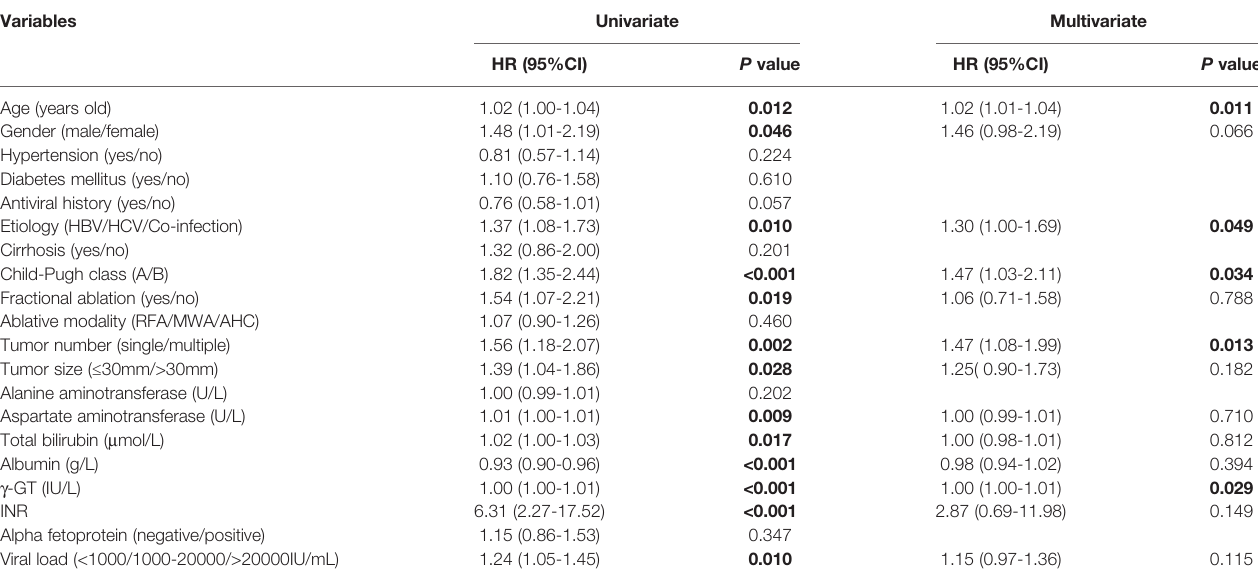
TABLE 3 | AFP at baseline as a prognostic factor associated with OS.